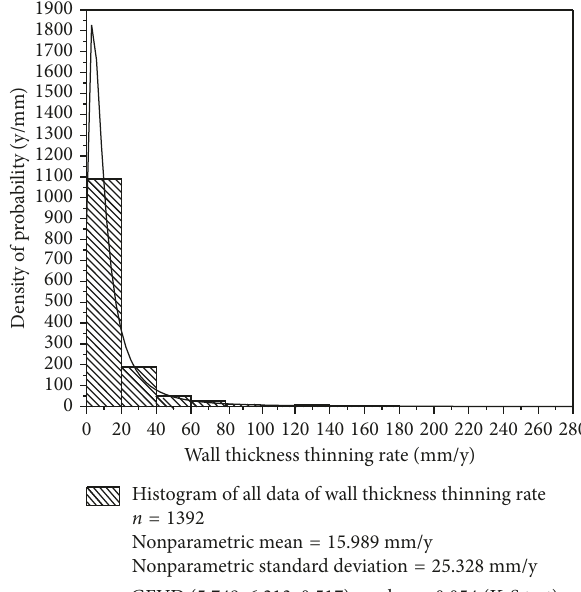
Figure 2: Wall Thickness Thinning Rate in all data for all heat exchanger analyzed (all the Probability Density Function (PDF) values plotted in this paper were adjusted in order for the distri- bution to “look like” the histogram. To do this, it is necessary to convert the PDF to the histogram’s size using the bins’ width and the number of bins. Reference [44] explains this process in